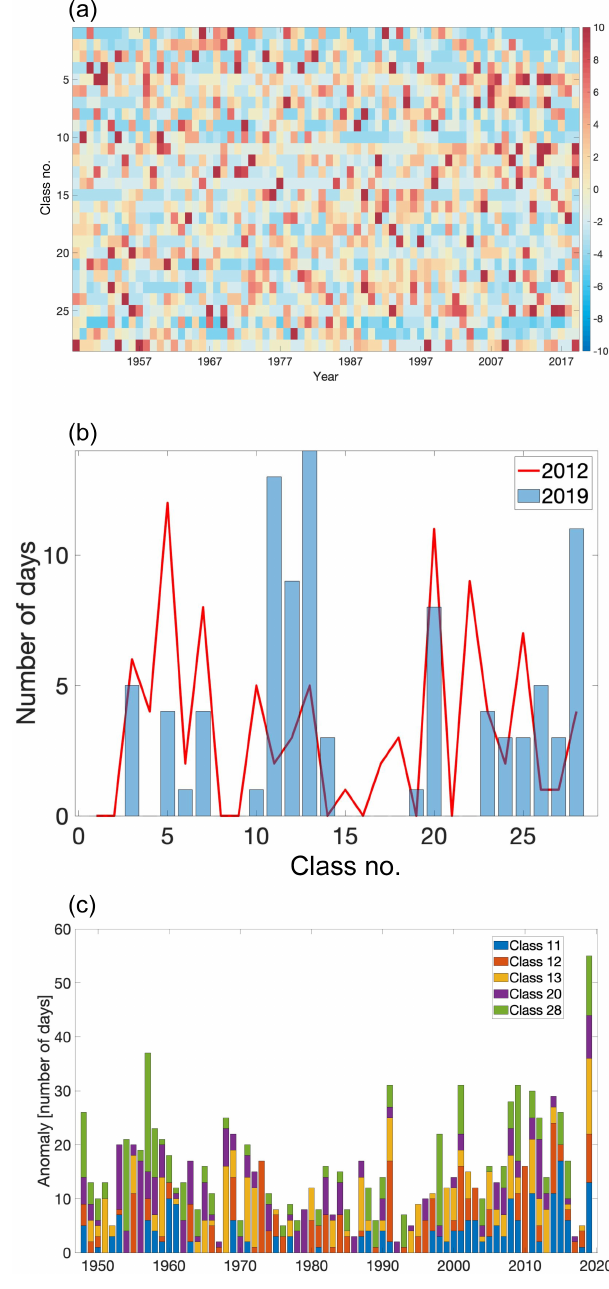
Figure 15. (a) Anomaly of the number of days (1981–2010 base- line) of the occurrence of each of the 28 classes identified through the SOM analysis for the years 1948–2019. (b) Number of days when the 28 identified classes ( x axis) occur during the summers of 2012 (red line) and 2019 (blue bars). (c) Anomaly of the number of days for class nos. 11, 12, 13, 20, and 28 for the period